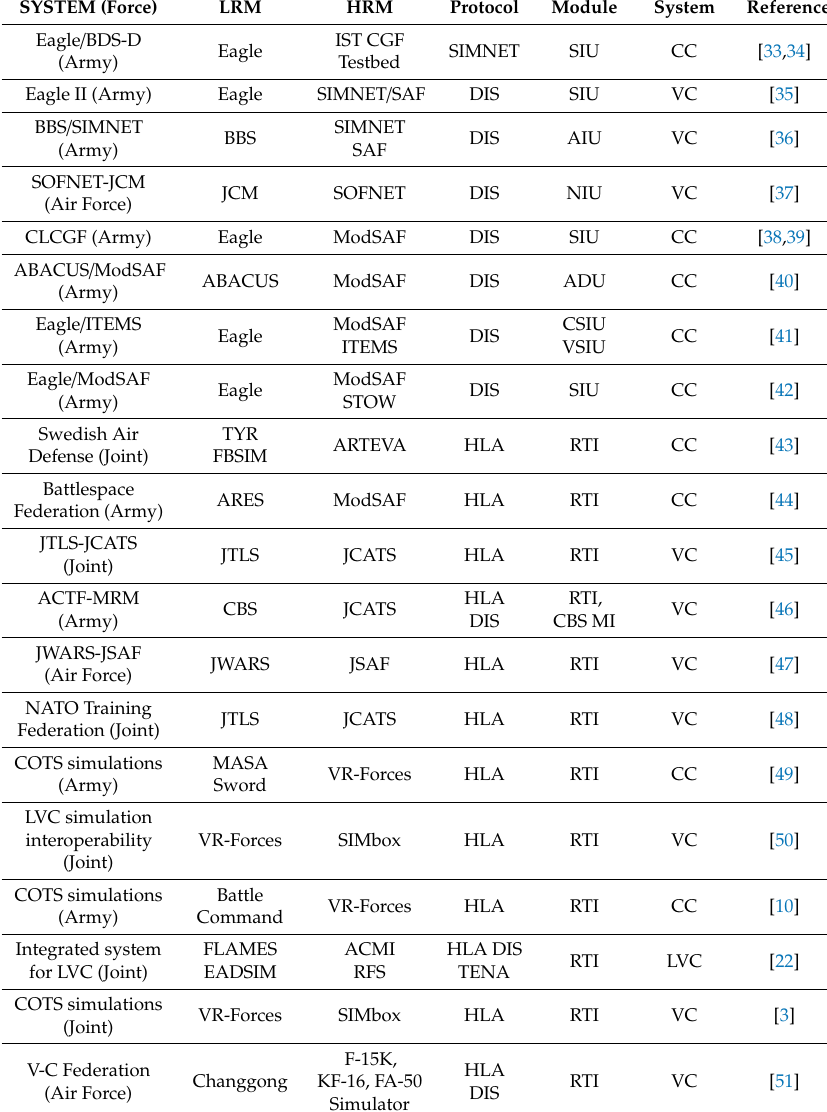
Table 2. Major MRM